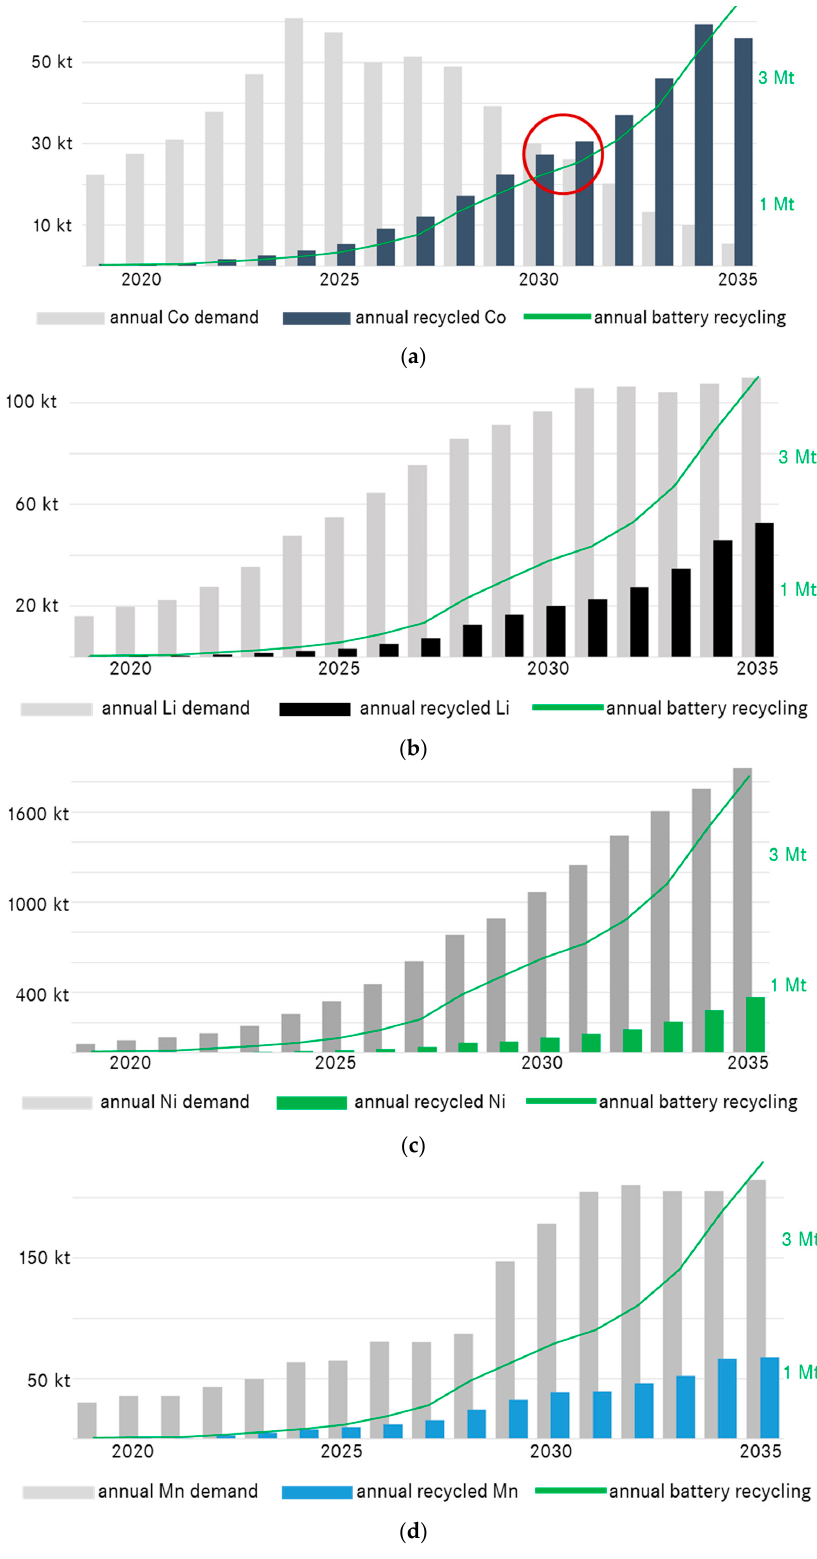
Figure 3. Raw-material demand vs. availability of secondary raw material worldwide and total annual battery recycling in green all in t; ( a ) Cobalt with intersection marked in red; ( b ) Lithium; ( c ) Nickel; ( d )